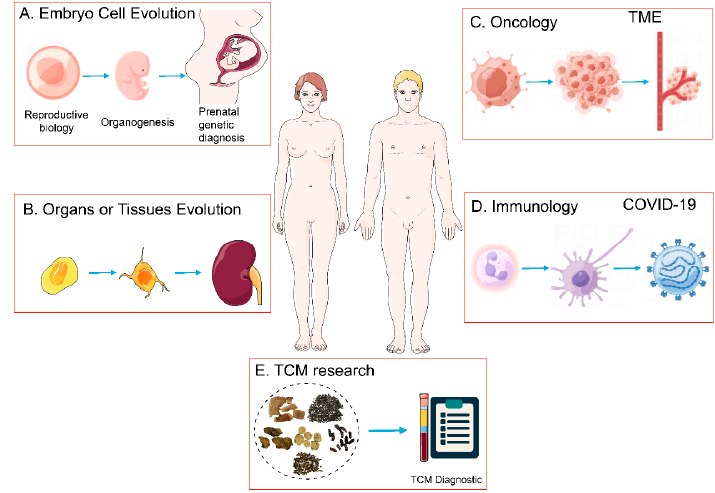
Figure 3. Application of single-cell RNA-sequencing technology. ( A ) Embryonic development. ( B ) Tissue and organ development. ( C ) Oncology. ( D ) Immunology. ( E ) TCM research.